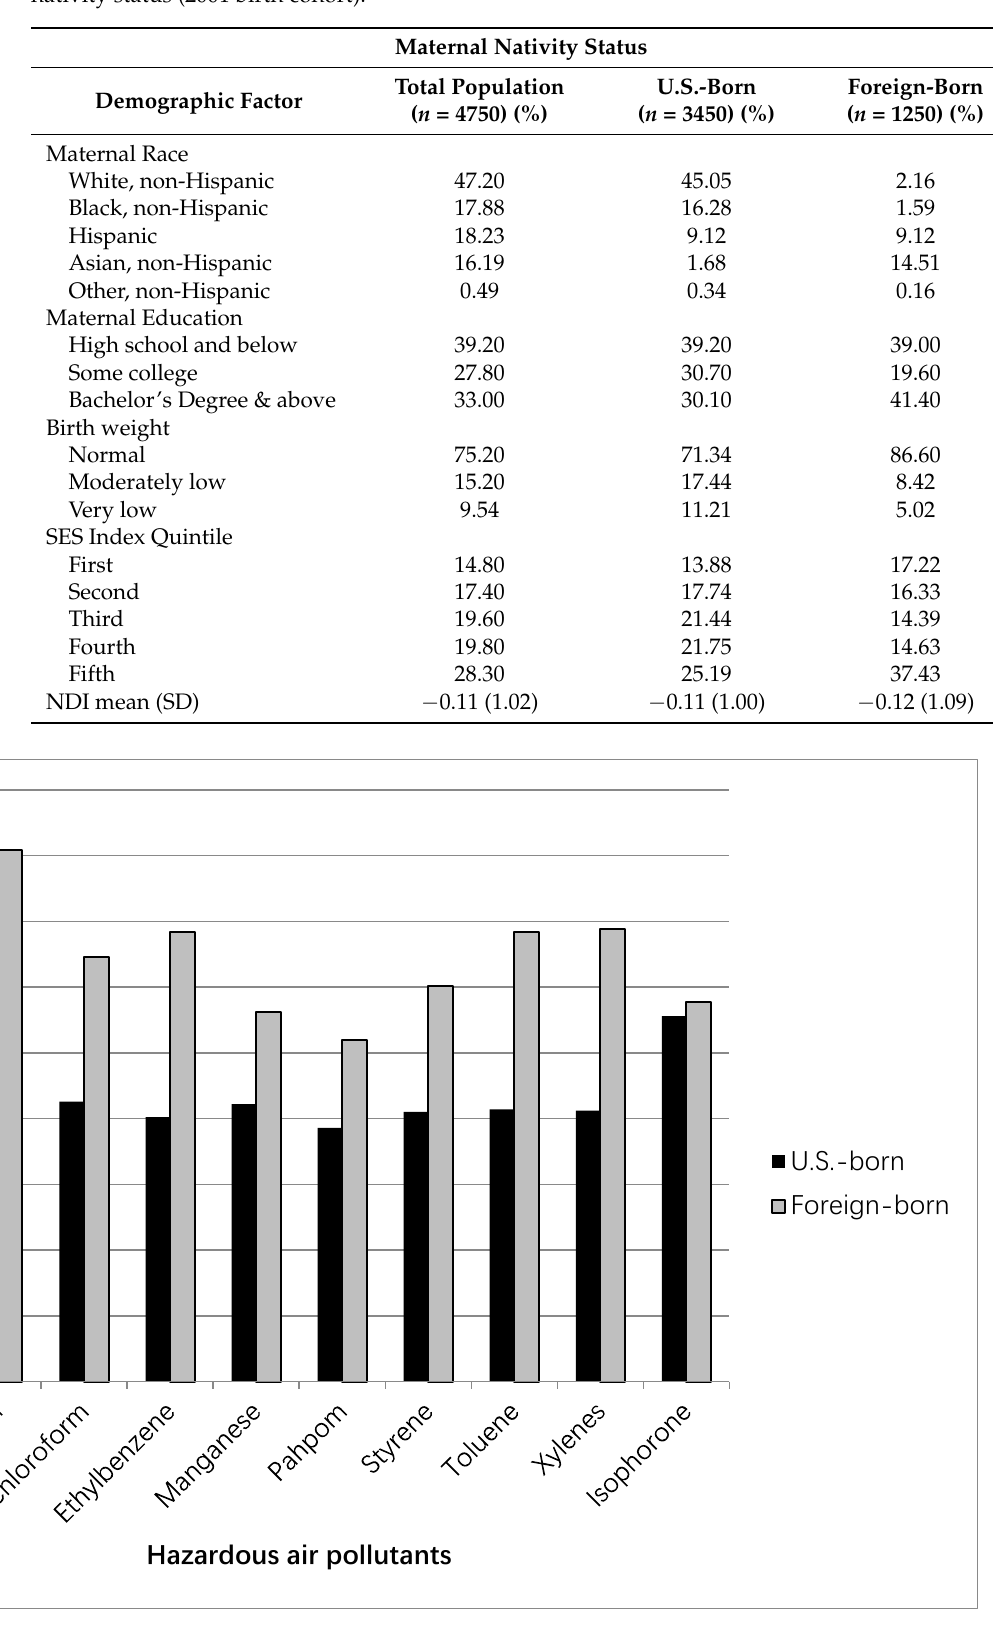
Figure 2. Highest quartile exposure to hazardous air pollutants by maternal nativity status in the ECLS-B population, by nativity status (2001 birth cohort).